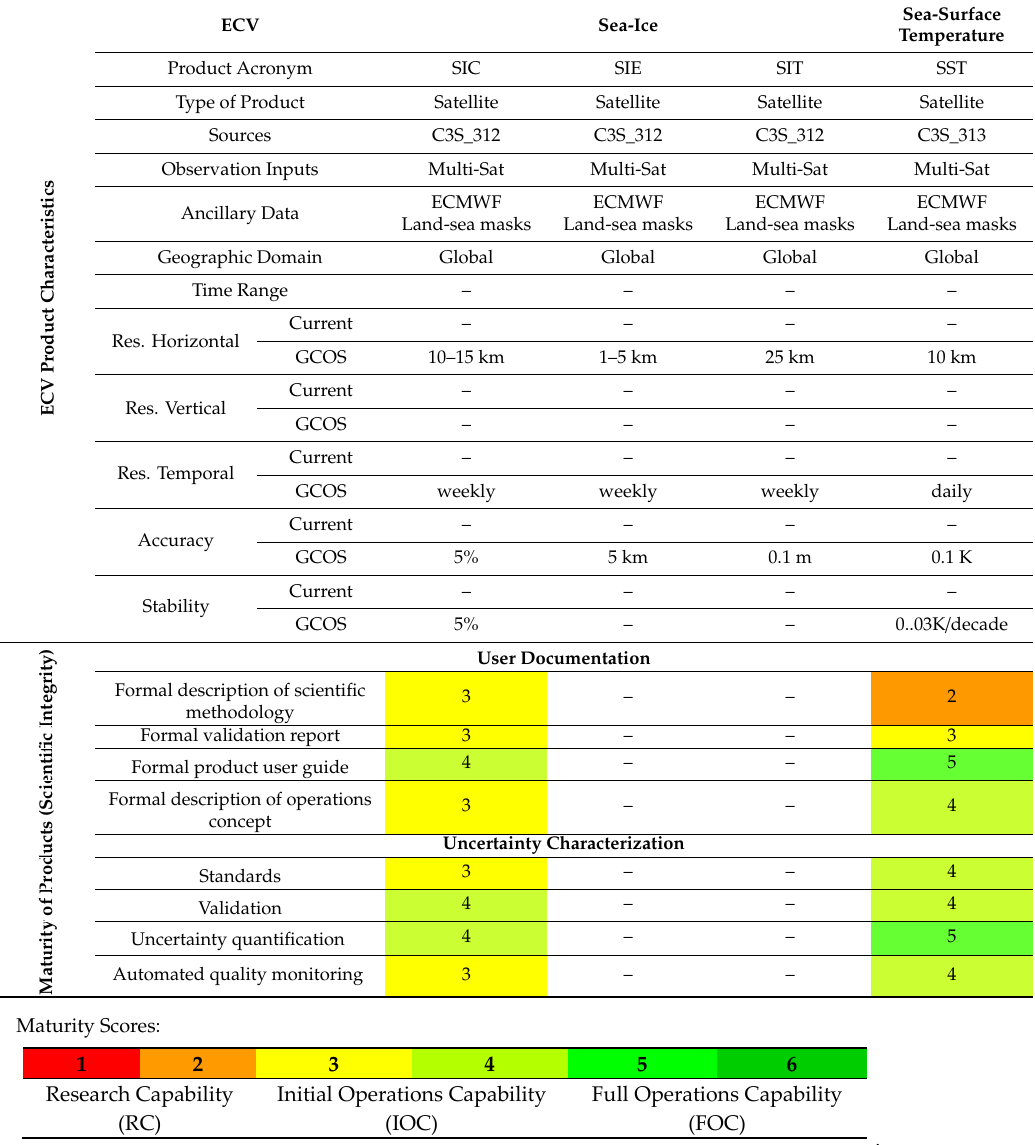
Table 3. Example of the overview of thematic ECV products to provide first level information on “ECV product Characteristics” and “Maturity of Products (Scientific Integrity).” (Note: The ECV product